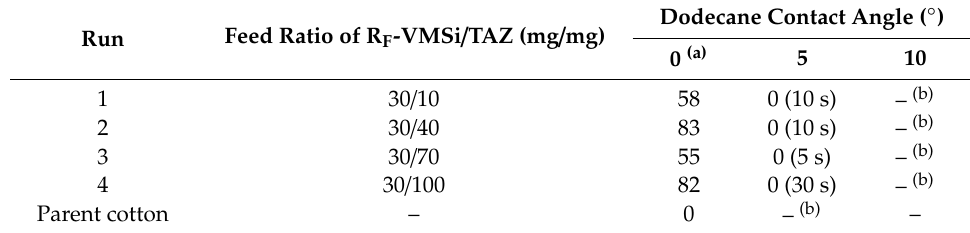
Table 2. Dodecane contact angles on the modified cotton fabric with the R F -VMSiO 2 /TAZ nanocomposites.